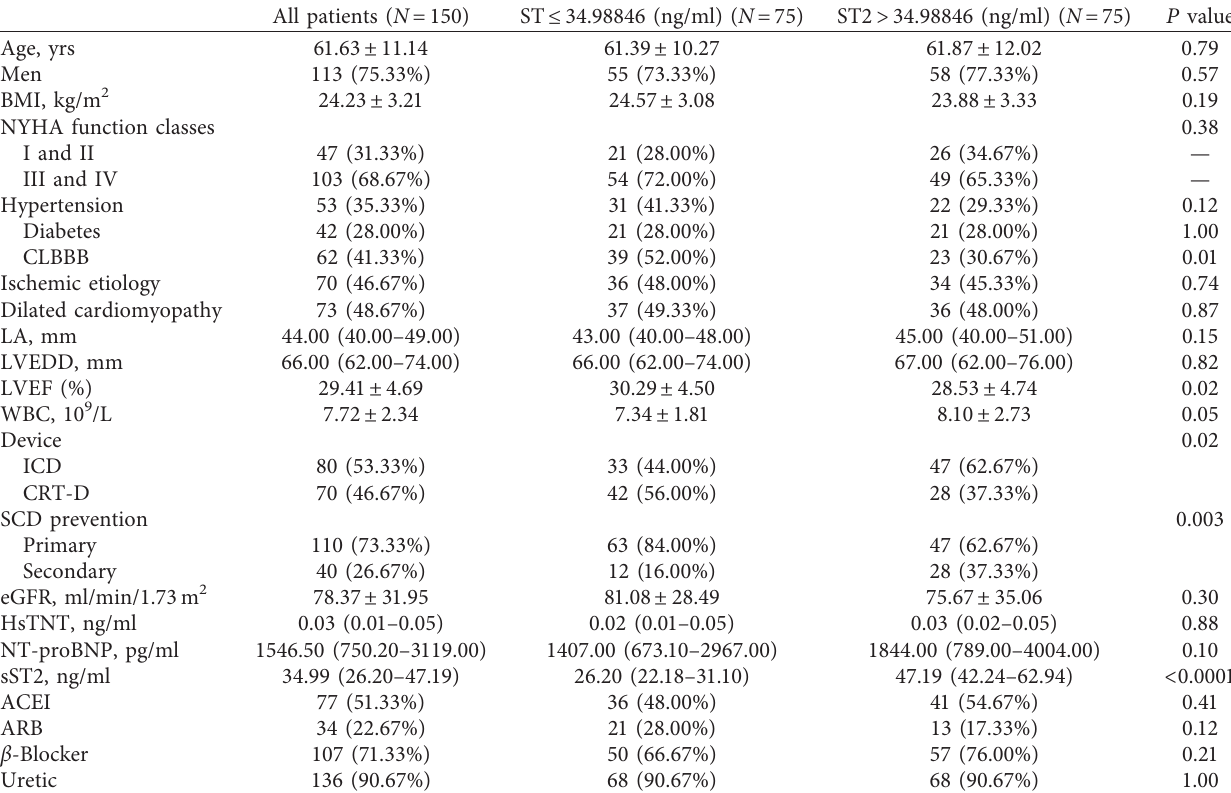
Table 1: Baseline characteristics and medical management according to the median levels of sST2.